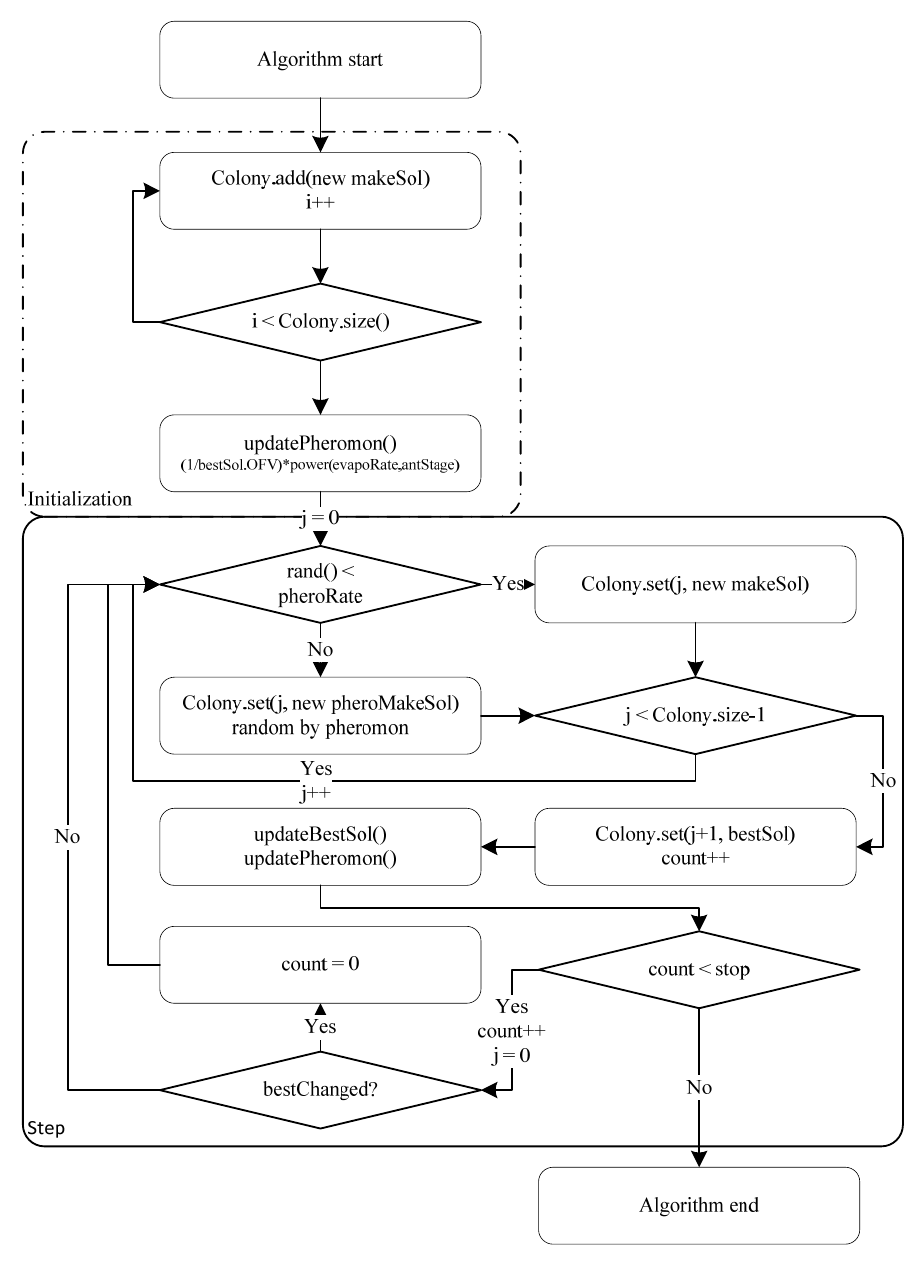
Figure 6. The flowchart of ACO.